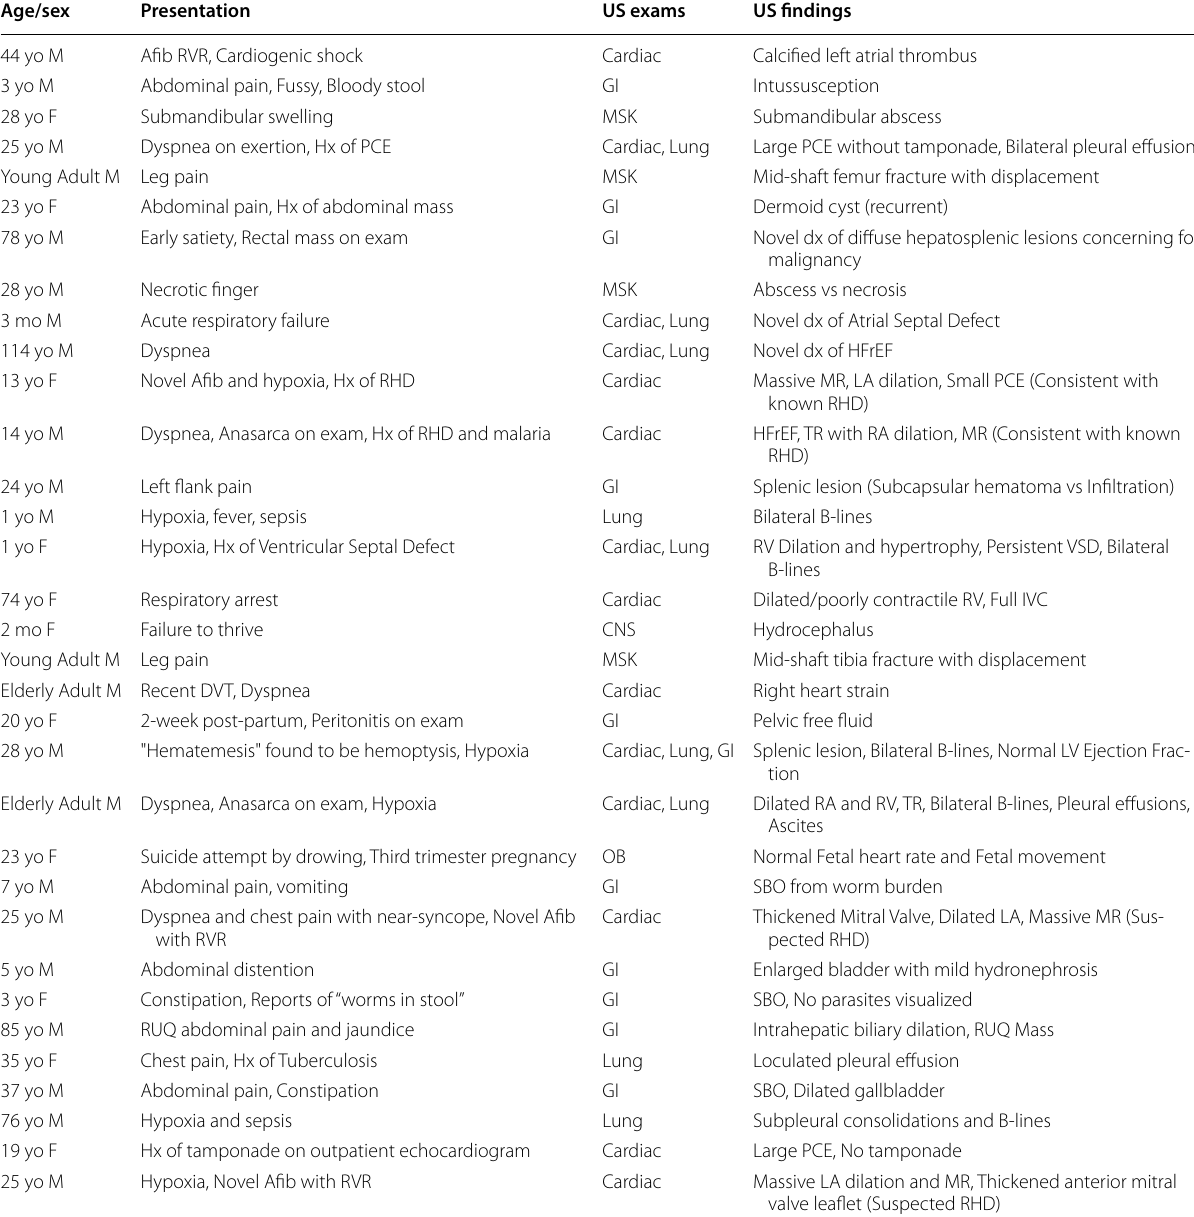
Afib, Atrial fibrillation; CNS, Central Nervous System; Dx, Diagnosis; HFrEF, Heart Failure with Reduced Ejection Fraction; GI, Gastrointestinal/Genitourinary; Hx, History; IVC, Inferior Vena Cava; LA, Left Atrium; MR, Mitral Regurgitation; MSK, Musculoskeletal/Soft tissue; OB, Obstetric; PCE, Pericardial Effusion; RA, Right Atrium; RHD, Rheumatic Heart Disease; RUQ, Right Upper Quadrant; RV, Right Ventricle; RVR, Rapid Ventricular Response; SBO, Small Bowel Obstruction; TR, Tricuspid